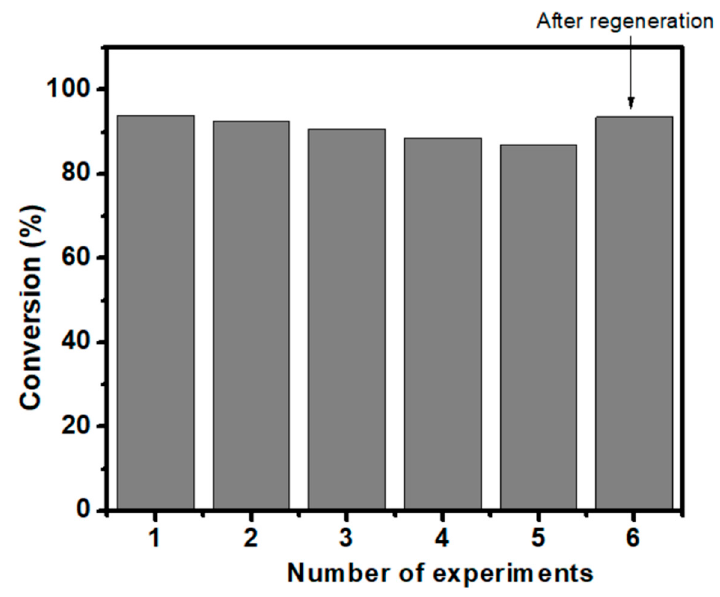
Figure 11. Catalyst reusability tests by using waste oil, 5 wt% of catalyst, at 65 °C and a reaction time of 3 h.